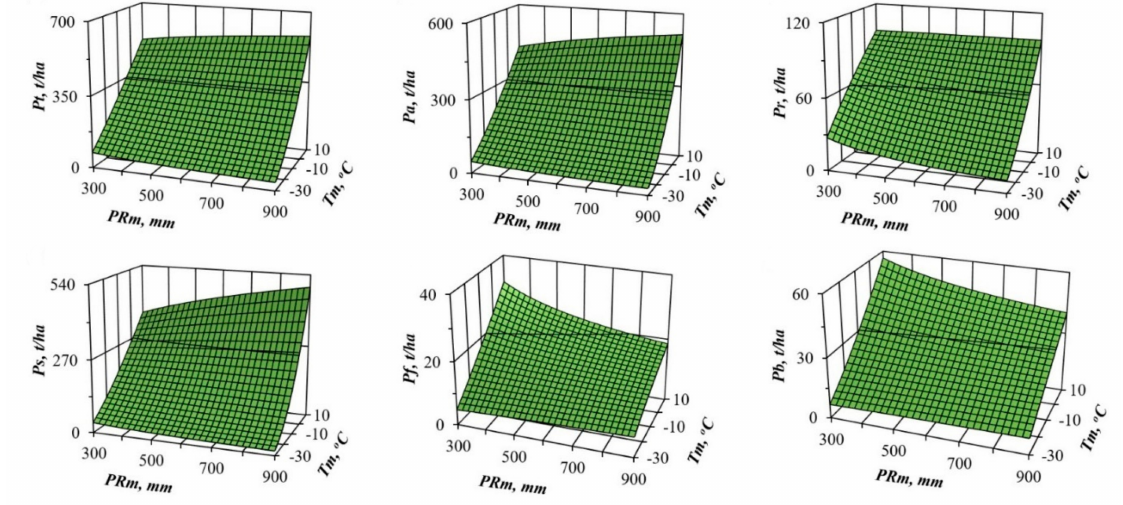
Figure 3. The relation of spruce biomass to the averaged temperature of January ( Tm ) and precipitation ( PRm ) at the stand age of 100 years. Designations: Pt , Pa , Pr , Ps , Pf and Pb are the biomass of total (above- and underground) wood storey, aboveground storey, underground storey (roots), stems (wood and bark), foliage and branches correspondingly, t per